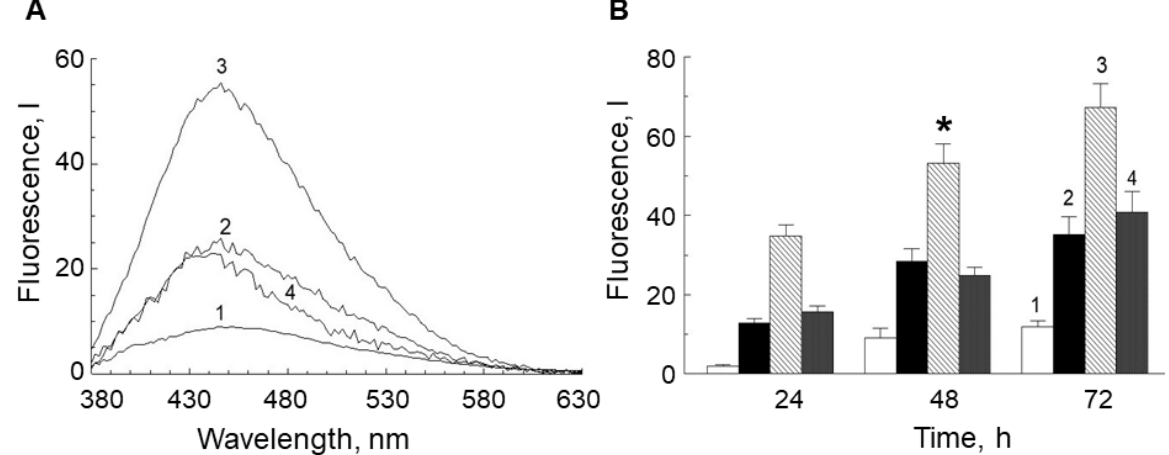
Figure 7. ( A ) Fluorescence spectra of photoreceptor outer segment (POS) suspensions after 48 h incubation in the dark with (1) control without additives; (2) supernatant from the original lipofuscin granule (LG) suspension; (3) supernatant from LG suspension irradiated with visible light for 60 min; and (4) supernatant from LG suspension irradiated with visible light for 60 min, and in the presence of aminoguanidine (4 mM). The fluorescence excitation wavelength was 365 nm. ( B ) Dynamics of the increase in intensity of POS suspension fluorescence after incubation in the dark for 24, 48, and 72 h. The column designations correspond to the designations of the samples on panel ( A ). Data are presented as means ± SD from three independent experiments. * р < 0.05.